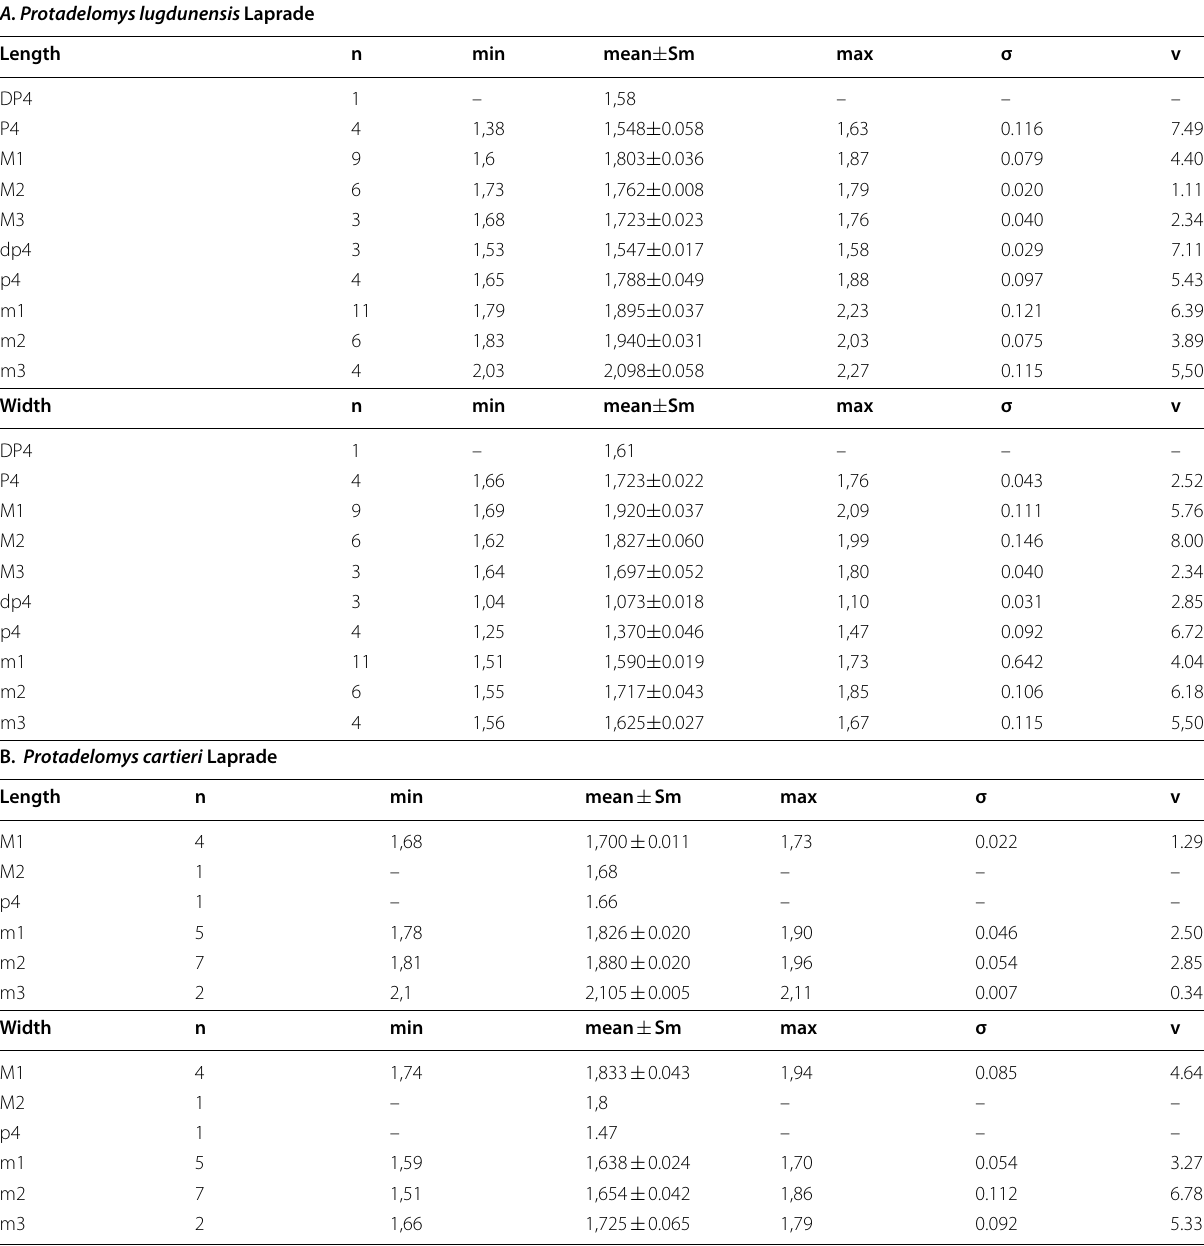
Table 3 Range of the size variations (length and width: min., max.; average loci of teeth of Protadelomys lugdunensis Hartenberger, 1969 and B. length and width for some loci only of Protadelomys